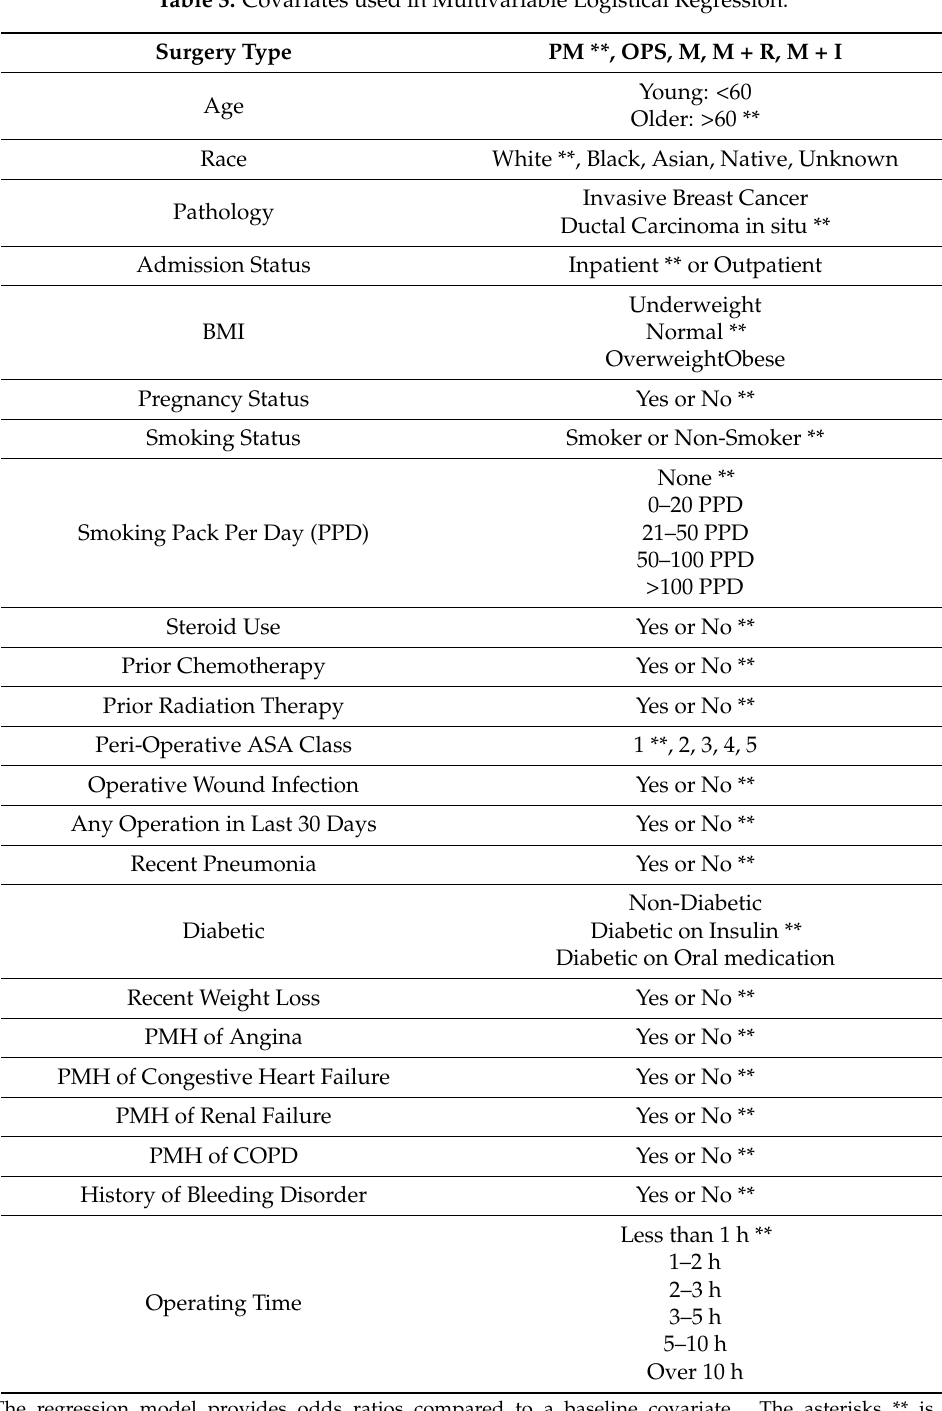
Table 3. Covariates used in Multivariable Logistical